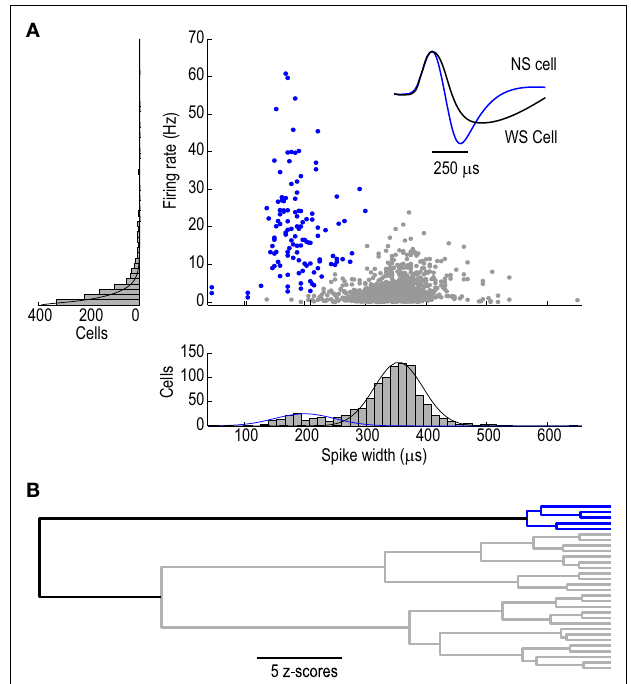
FIGURE 1 | Identifi cation of putative interneurons. (A) Average fi ring rate of a neuron plotted as a function of the cell’s average spike width yielding two distinct populations of cortical cells corresponding to putative narrow-spiking (NS) interneurons (blue) and wide-spiking pyramidal cells (P, gray). Example of average waveforms (upward defl ections indicate inward current) for a single putative interneuron (blue) and pyramidal cell (gray) are shown as an inset with scale bar. Distributions of fi ring rates and spike widths are shown to the left and bottom of the scatter plot respectively. (B) Dendrogram depicting the clustering of cortical neurons into two groups corresponding to narrow-spiking (NS, blue) and wide-spiking (WS, gray) cells. Scale bar indicates average Euclidian distance between